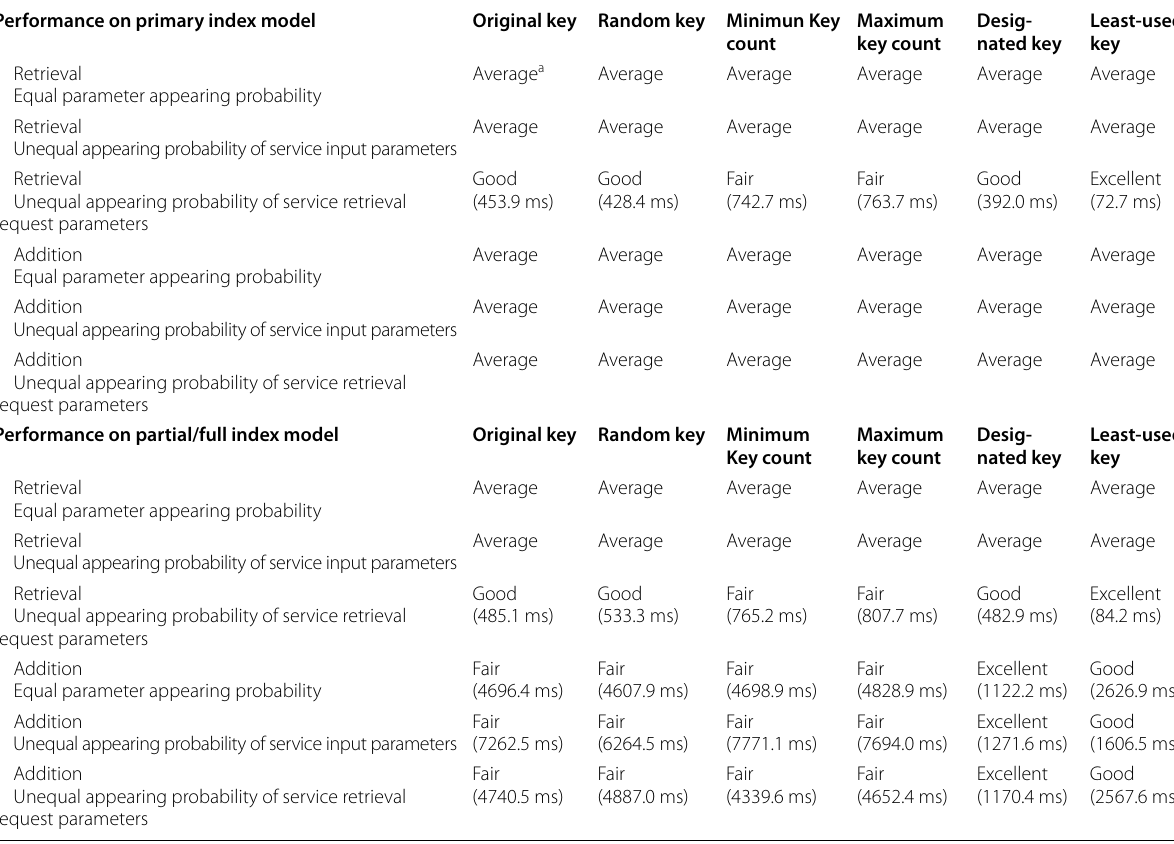
Table 1 Retrieval and addition performances on primary/partial/full index models generated using the six key selection methods under different parameter